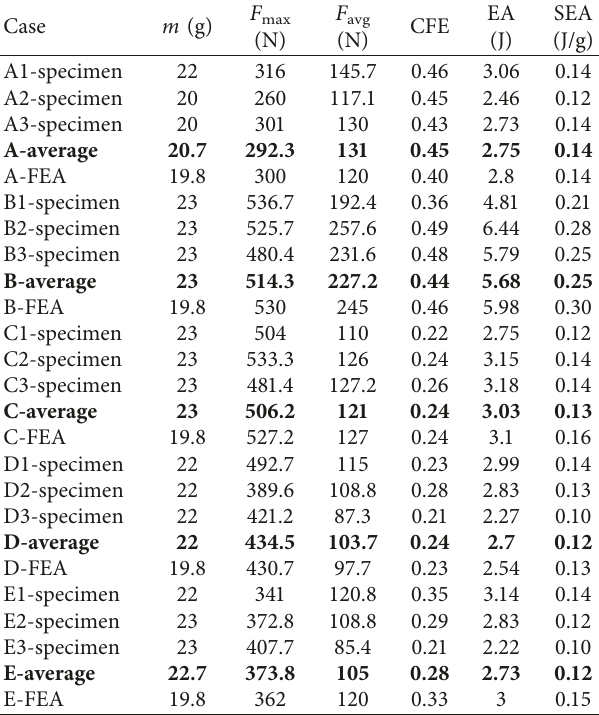
Table 4: Different fibre directions for FEA and experimental